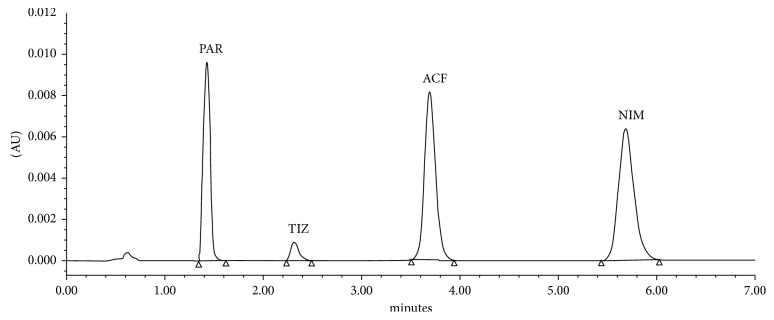
Typical UPLC chromatogram for simultaneous separation of PAR, TIZ, ACF, and NIM. Chromatographic conditions are as follows: ACQUITY UPLC BEH C18 column (100 mm × 2.1 mm, 1.7 μm); mobile phase consisting of acetonitrile : 20 mM phosphate buffer adjusted to pH 7.0 using dipotassium hydrogen phosphate (40 : 60 v/v); flow rate 1.25 mL·min−1; injection volume 2.0 μL; and PDA detection at 305 nm.